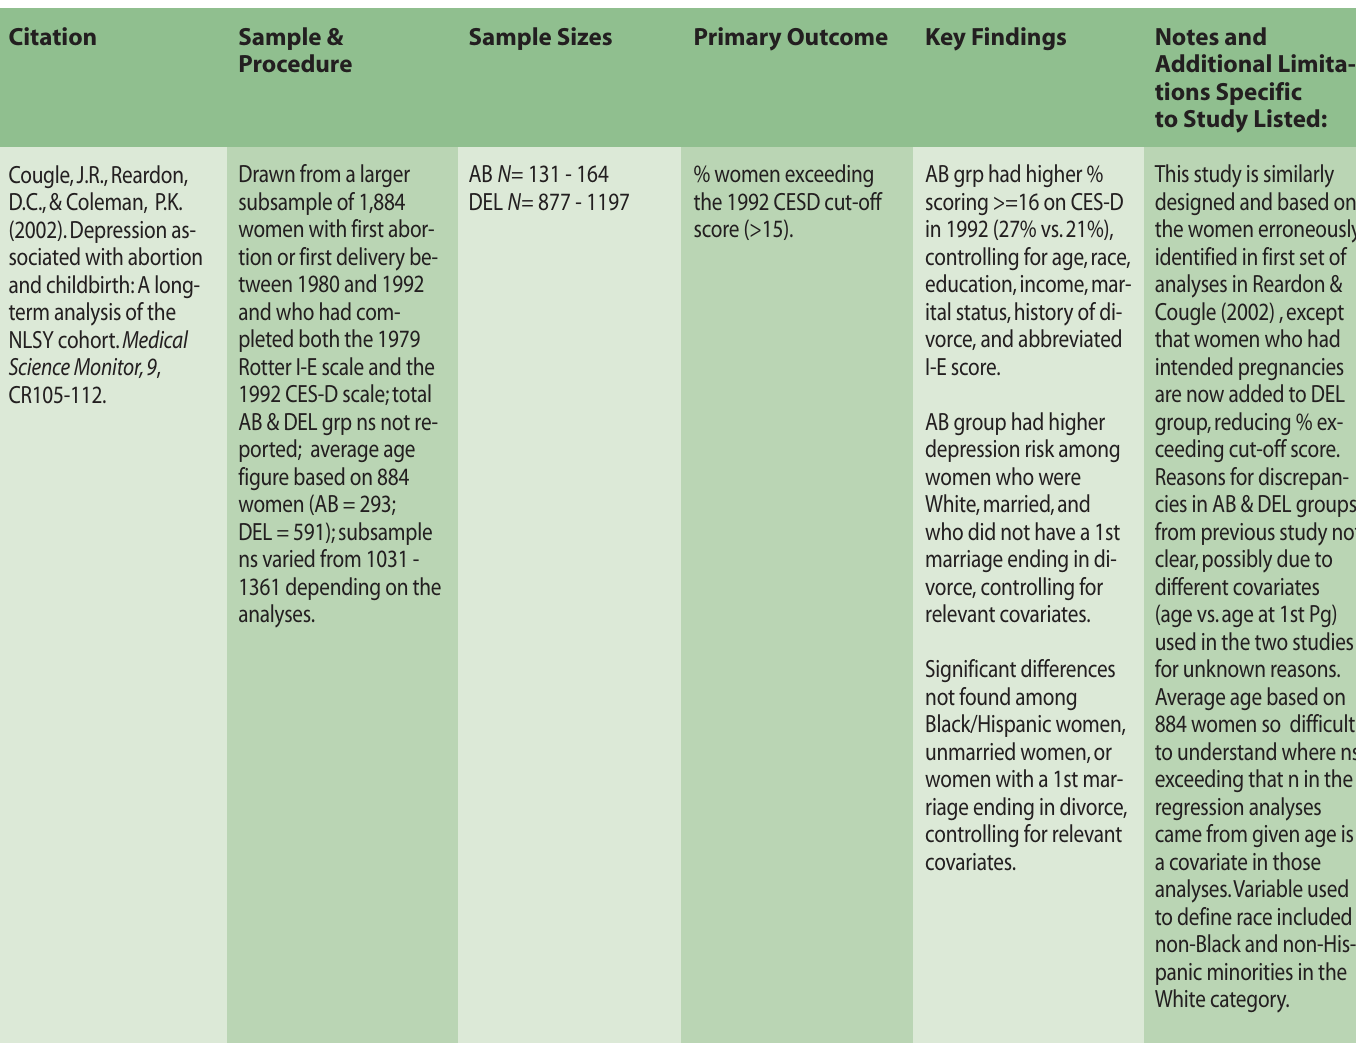
Table 1B: Secondary Analyses of Survey Data–Abortion vs.Comparison